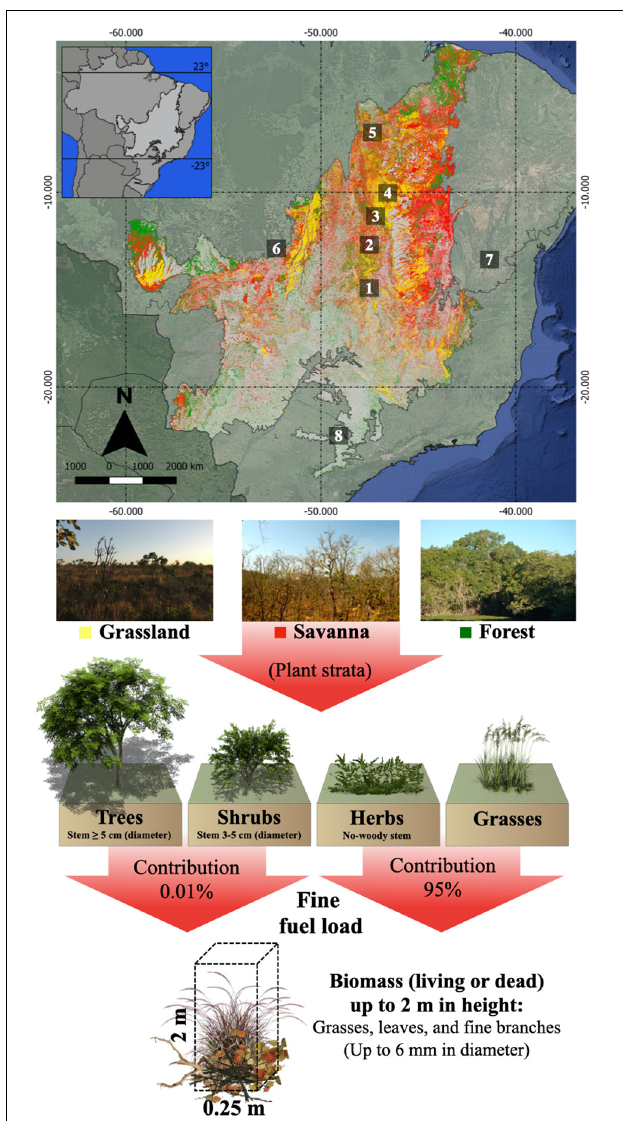
FIGURE 1 | Location of experimental fires carried out in the Brazilian Cerrado and distribution of the main types of vegetation in the Cerrado from MapBiomas (http://mapbiomas.org/), classification of vegetation strata in the savanna, and their contributions to the fine fuel composition (online version in color). (1) Ecological Reserve, Distrito Federal; (2) Serra do Tombador Nature Reserve, Goiás; (3) Água Limpa Ranch, Tocantins; (4) Jalapão State Park, Tocantins; (5) Chapada das Mesas National Park, Maranhão; (6) Tanguro Ranch, Mato Grosso; (7) Serra do Sincorá, Bahia, and (8) Ecological Station of Santa Bárbara, São Paulo. Descriptions of the study areas are shown in Supplementary Table S1